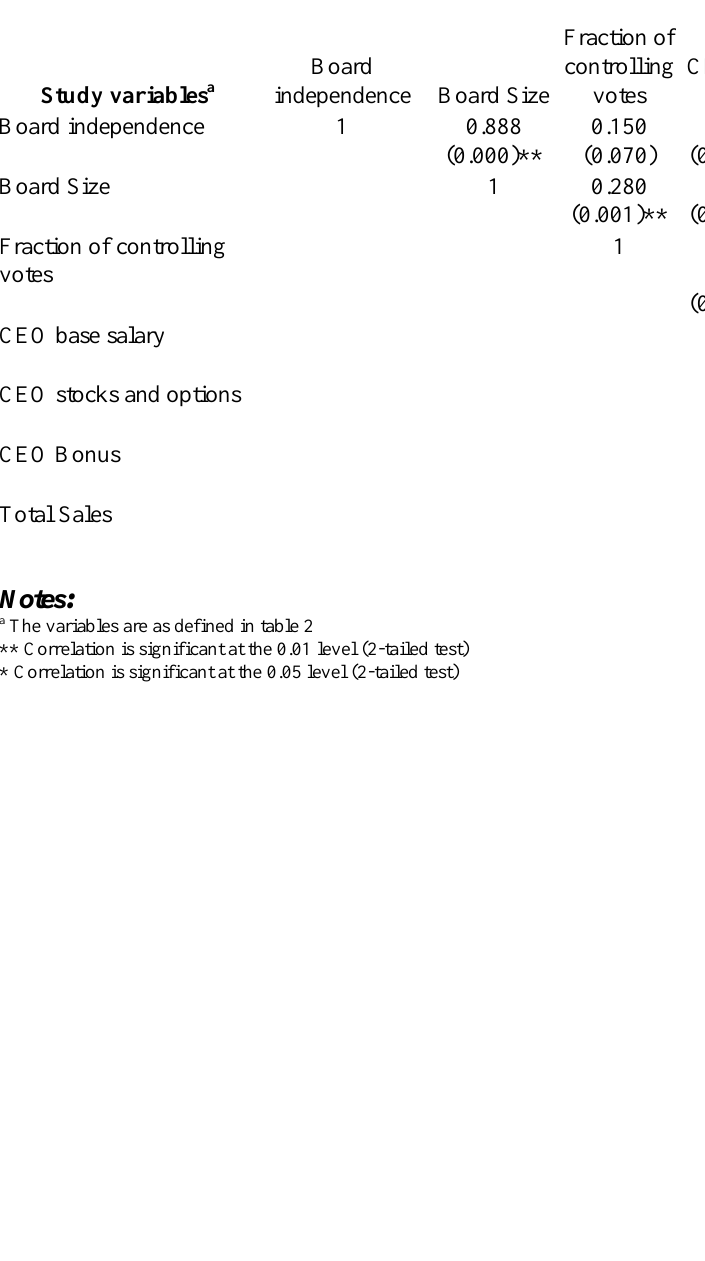
Table 3: Pearson Correlation Coefficients